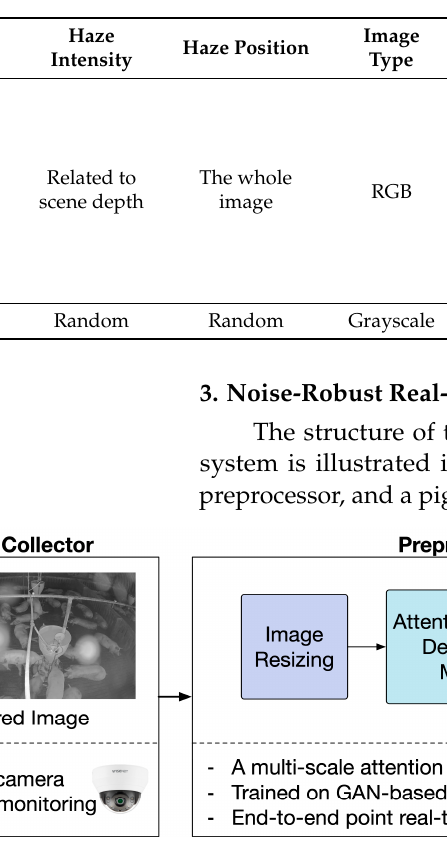
Table 1. Some recent studies on image dehazing (Published between 2011–2021).